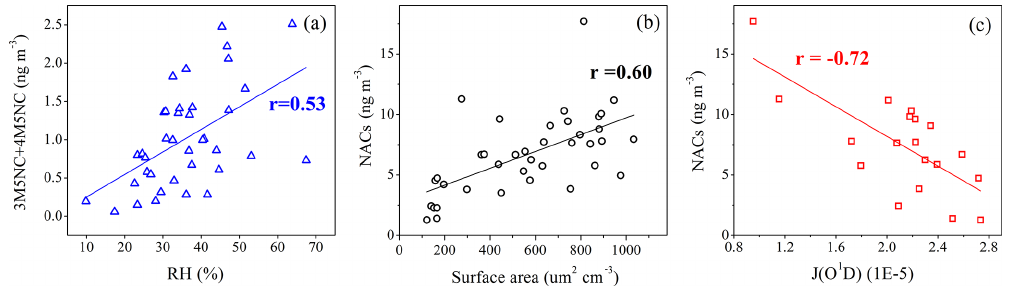
Figure 8. Correlation analysis (a) between (3M5NC + 4M5NC) and RH, (b) between NACs and aerosol surface area, and (c) between NACs and J(O 1 D)